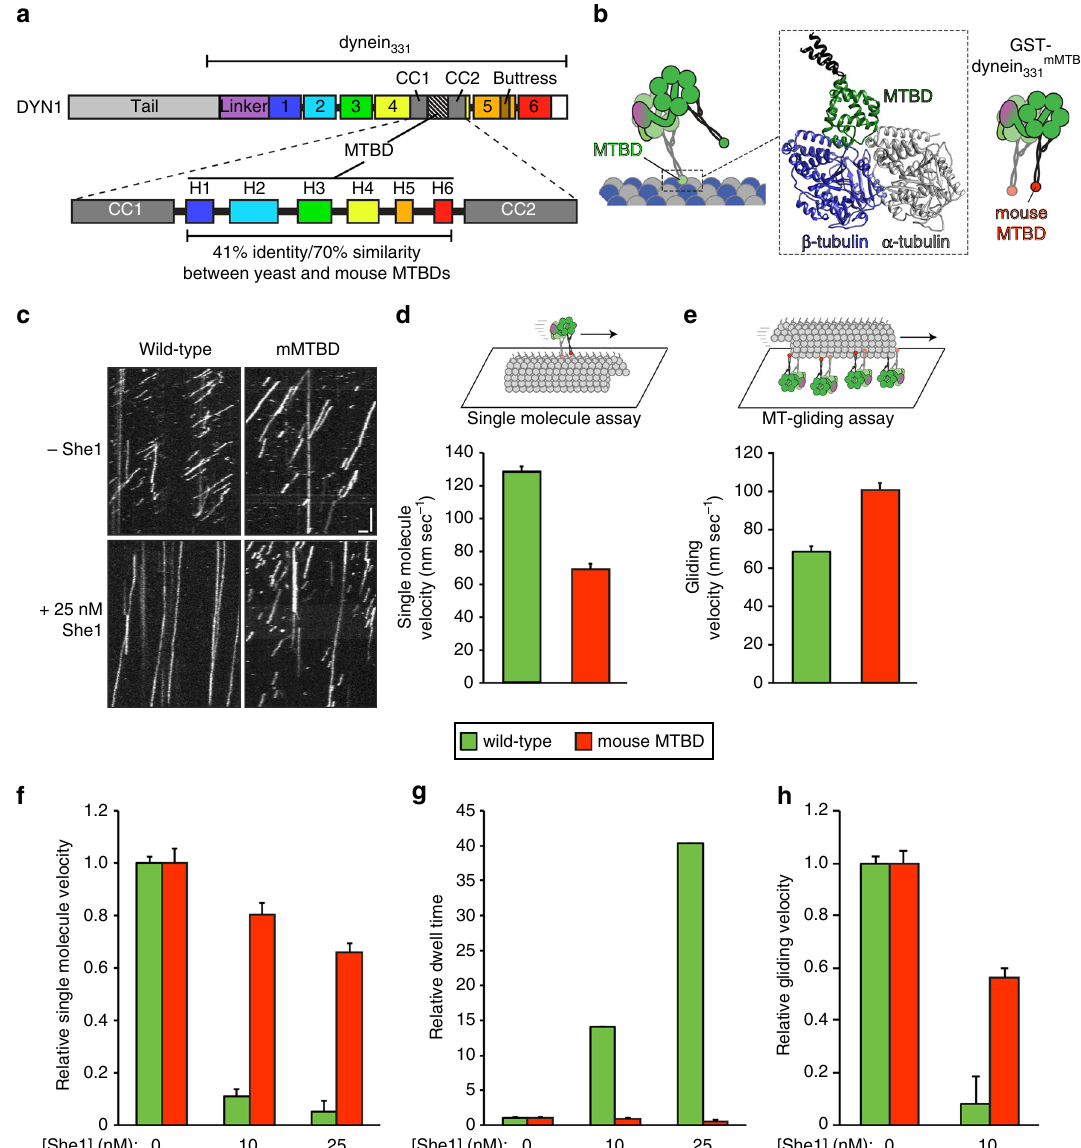
Fig. 6 A dynein motor with a mutated MTBD exhibits reduced She1 sensitivity. a Schematic representation of the yeast dynein heavy chain ( DYN1 ) with domain structure indicated (domains 1 – 6 represent the individual AAA domains; CC coiled coil; H1 – H6, helices that comprise the MTBD). b Cartoon representation with homology model of the yeast dynein MTBD bound to alpha and beta-tubulin (green, MTBD; dark gray, CC1 and CC2; generated using one-to-one threading of yeast DYN1 sequence into 3J1T 45 on the Phyre2 server 71 ). c Kymographs depicting single-molecule motility of GST – dynein 331 and GST – dynein 331 mMTBD in the absence (top) or presence (bottom) of 25 nM She1 (horizontal scale bar, 2 µ m; vertical scale bar, 1 min). d , e Plots depicting mean velocity of GST – dynein 331 and GST – dynein 331 mMTBD in single-molecule ( d ) and ensemble microtubule gliding assays ( e ; error bars, standard error). f , g Plots depicting effects of She1 on the relative velocity ( f ) and dwell time ( g ) of single molecules of GST – dynein 331 and GST – dynein 331 mMTBD . h Plot depicting effects of She1 on the relative microtubule gliding velocity of coverslip-immobilized GST – dynein 331 and GST – dynein 331 mMTBD (error bars, standard error; n ≥ 147 individual motors for each condition for single-molecule assay; n ≥ 21 microtubules for each condition for the ensemble motility assay); Supplementary Figs. 4 and